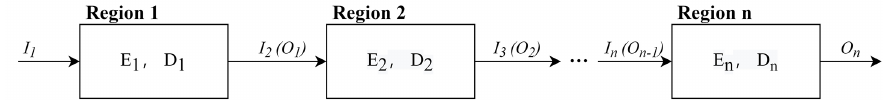
Figure 3. The sediment balance system in the study area (region n indicates the source area, transitional area or deposition area).